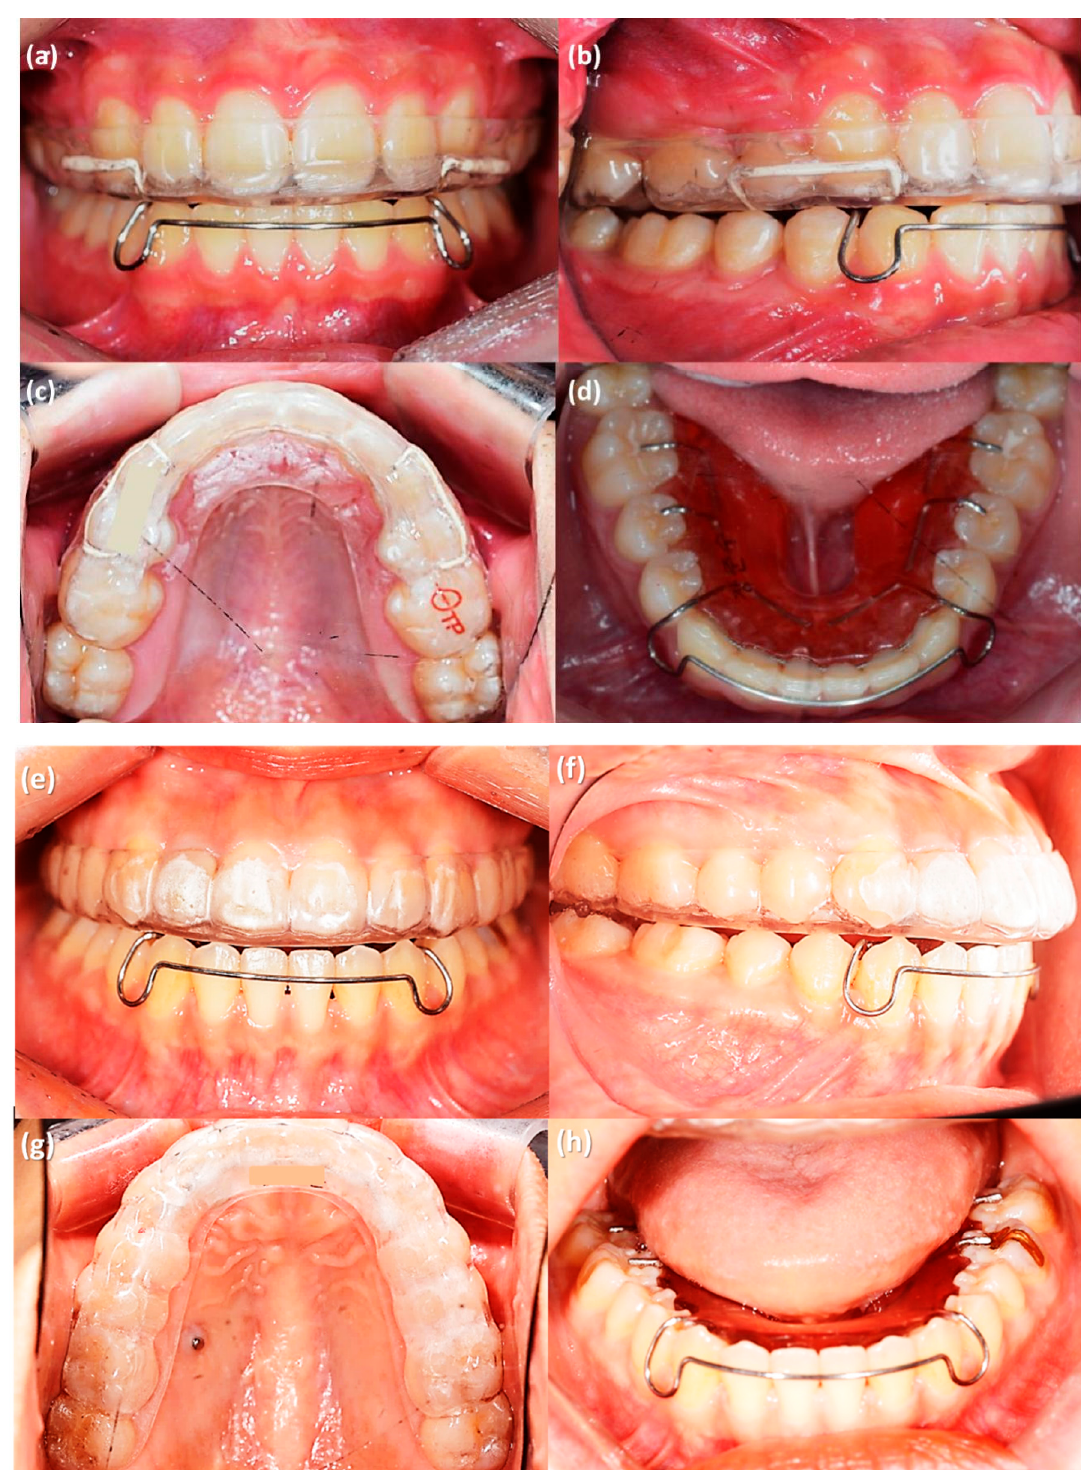
Figure 4. Removable retainers provided to the patients after orthodontic treatment. ( a – d ) Premolar extraction case, OTP retainer in the maxillary dentition ( a – c ) and tongue elevator for mandibular dentition ( d ). ( e – h ) Non-extraction case, OTP retainer in the maxillary dentition ( e – g ) and tongue elevator for mandibular dentition ( h ).